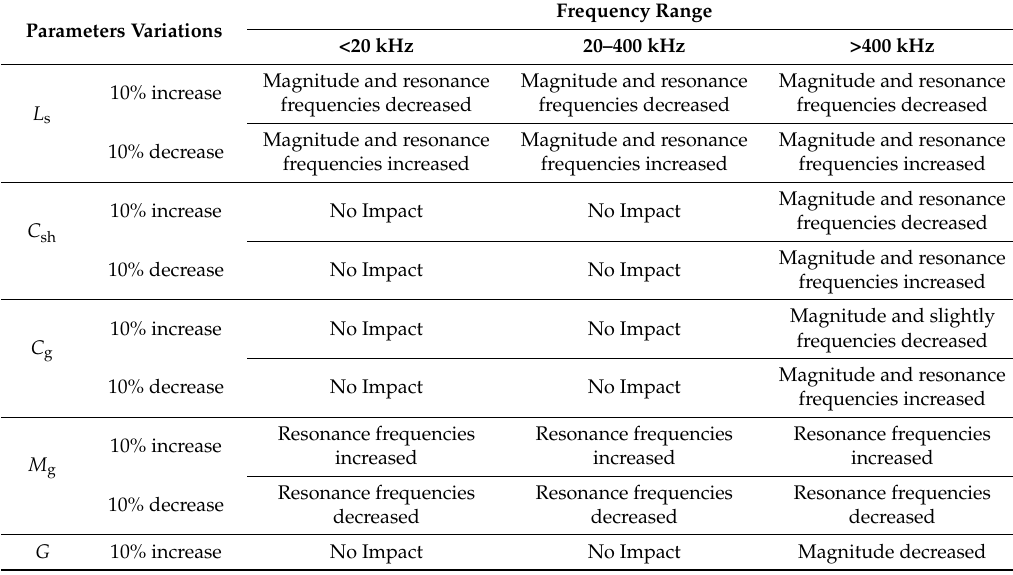
Table 3. Effects of change in electrical parameters on resonance frequency and magnitude [18].